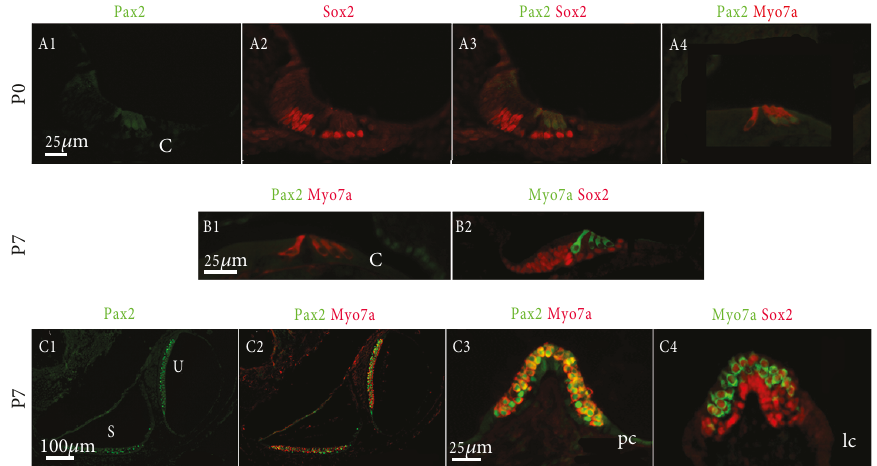
Figure 6: Pax2 and Sox2 gene expression patterns in the neonatal mouse inner ear (P0-P7). Scale bars =25 μ m (A1 – A4, B1 – B2, and C3 – C4); 100 μ m (C1 –